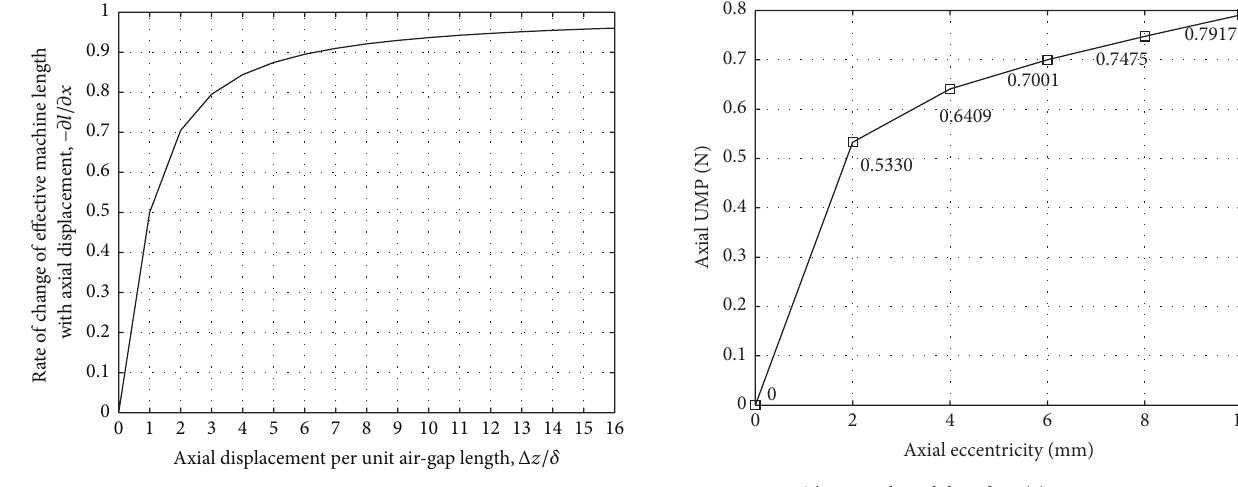
Figure 4: Change rate of effective machine length due to AAGE.